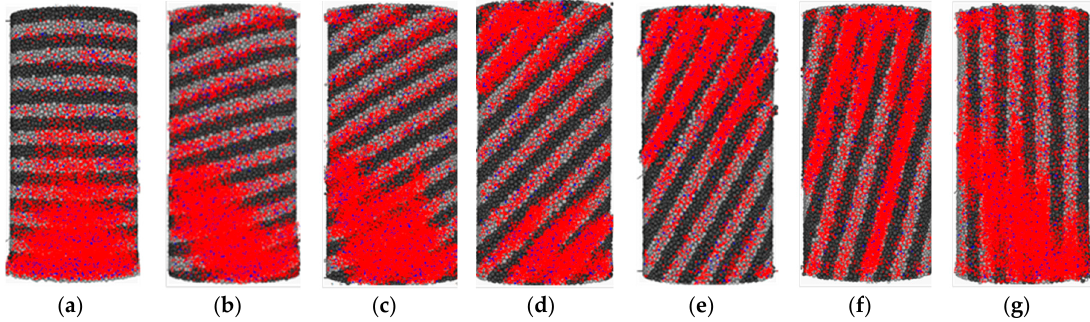
Figure 16. Failure modes of transversely isotropic rocks without weak interfaces: ( a ) α = 0 ◦ , ( b ) α = 15 ◦ , ( c ) α = 30 ◦ , ( d ) α = 45 ◦ , ( e ) α = 60 ◦ , ( f ) α = 75 ◦ , and ( g ) α = 90 ◦ .